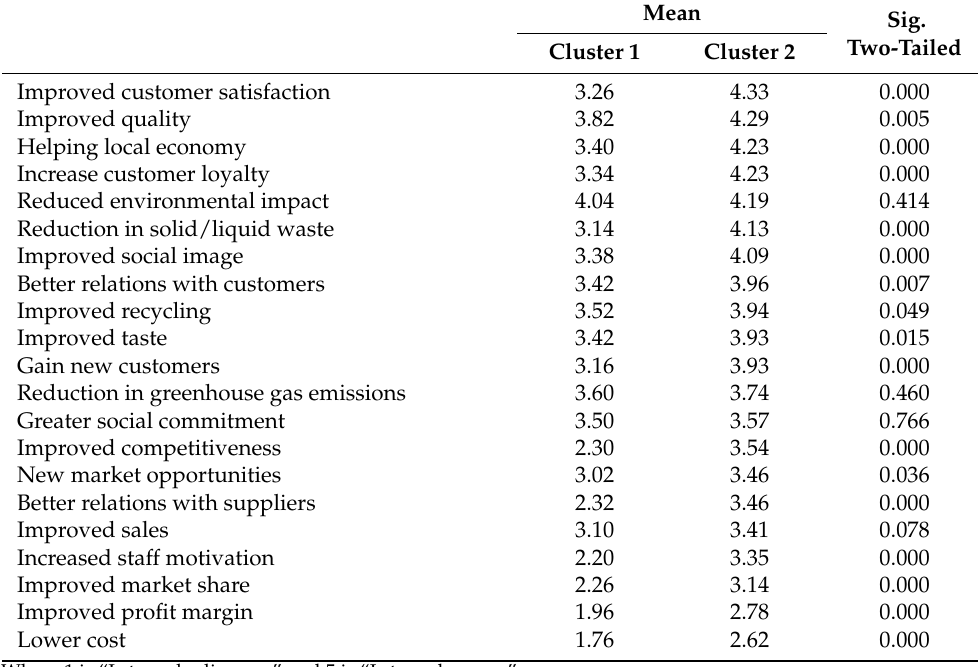
Table 5. Benefits derived from sustainable